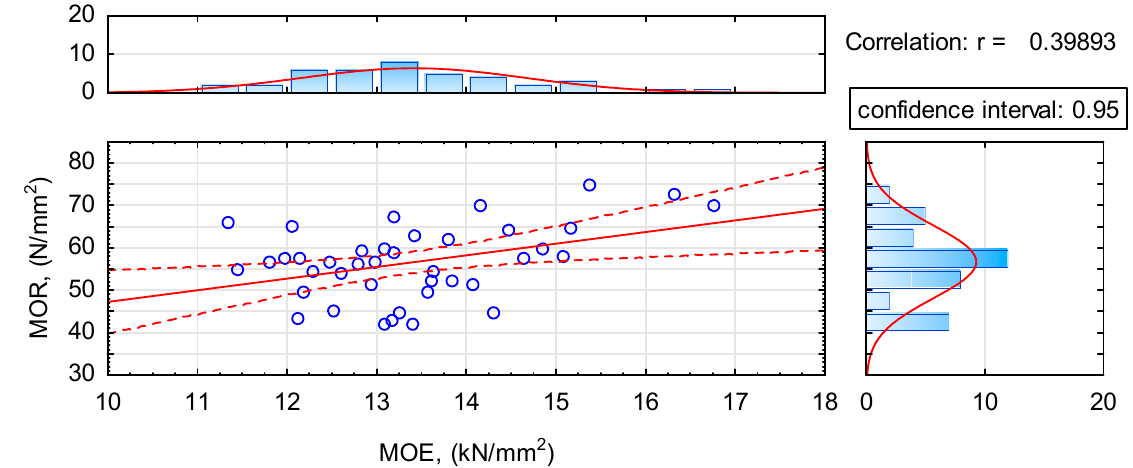
Figure 10. The dependence of strength on the modulus of elasticity.